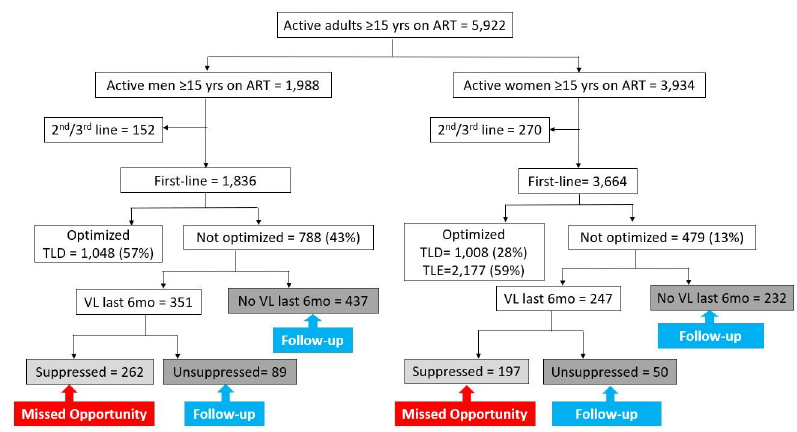
Fig 2. Example of the use of the enhanced data system to monitor antiretroviral drug optimization transition, by sex, at Jaramogi Oginga Odinga Teaching and Referral Hospital (JOOTRH), Kisumu, Kenya, February 2019. ART: antiretroviral treatment; JOOTRH: Jaramogi Oginga Odinga Teaching and Referral Hospital; TLD: tenofovir +lamivudine+dolutegravir; TLE: tenofovir+lamivudine+efavirenz; VL: Viral load.